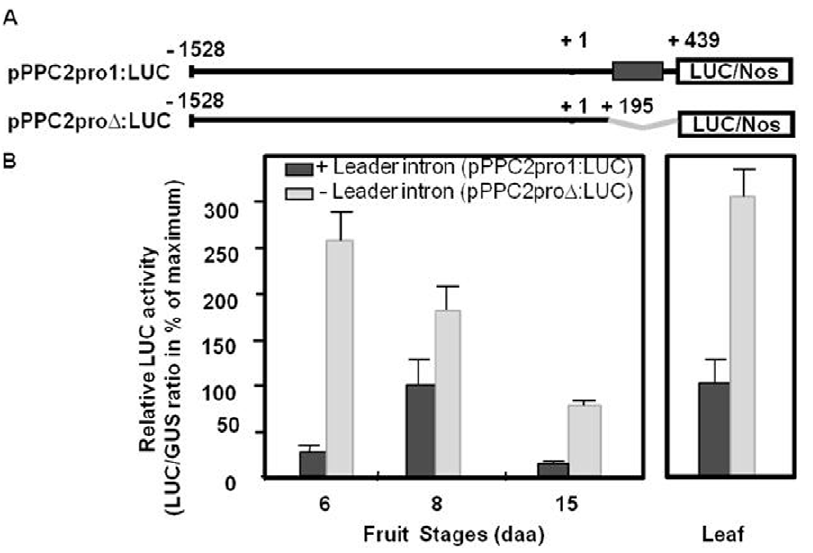
Figure 5. Transient reporter-gene expression analysis of the SlPPC2 promoter deleted from its leader intron in developing tomato fruit and in leaf. (A) Details of the constructs. (B) Young leaf discs and slices of tomato fruit («WVa 106» cherry) at the indicated stages of development were transformed by biolistic with the –1528 to + 439 construct (pPPC2pro1:LUC, in black) or with the –1528 to + 195 construct (pPPC2pro D :LUC, in grey) as indicated in Figure 1. Data are expressed as % of the pPPC2pro1:LUC activity at 8 daa. The mean values and SE of 10 independent transformations are shown.